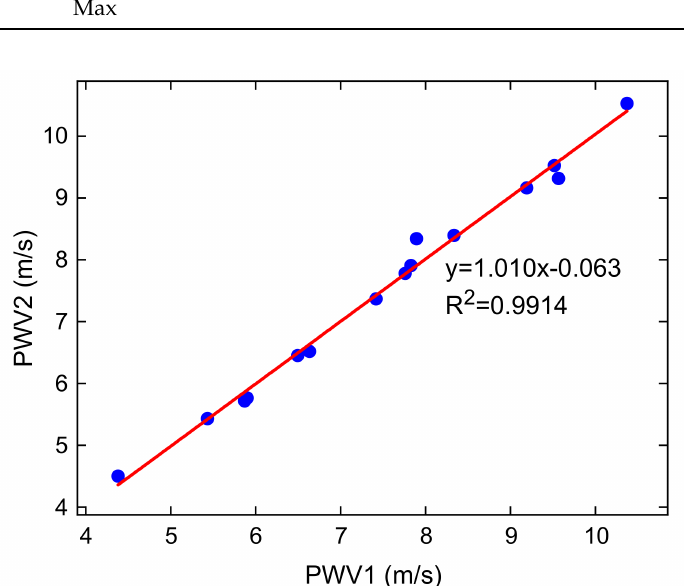
Figure 17. The fitting result of the two PWV